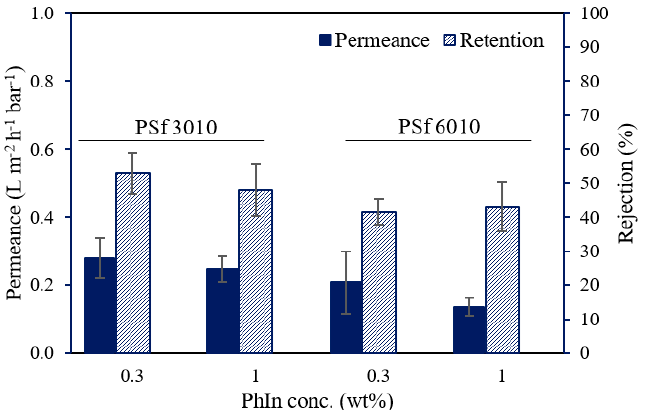
Figure 1. Water permeance and RB rejection of UV-cured PSf (10 wt%) membranes synthesized with 5 wt% XL, different PSf types (PSf Ultrason ® S 3010 or 6010), and different PhIn concentrations (0.3 or 1 wt%).